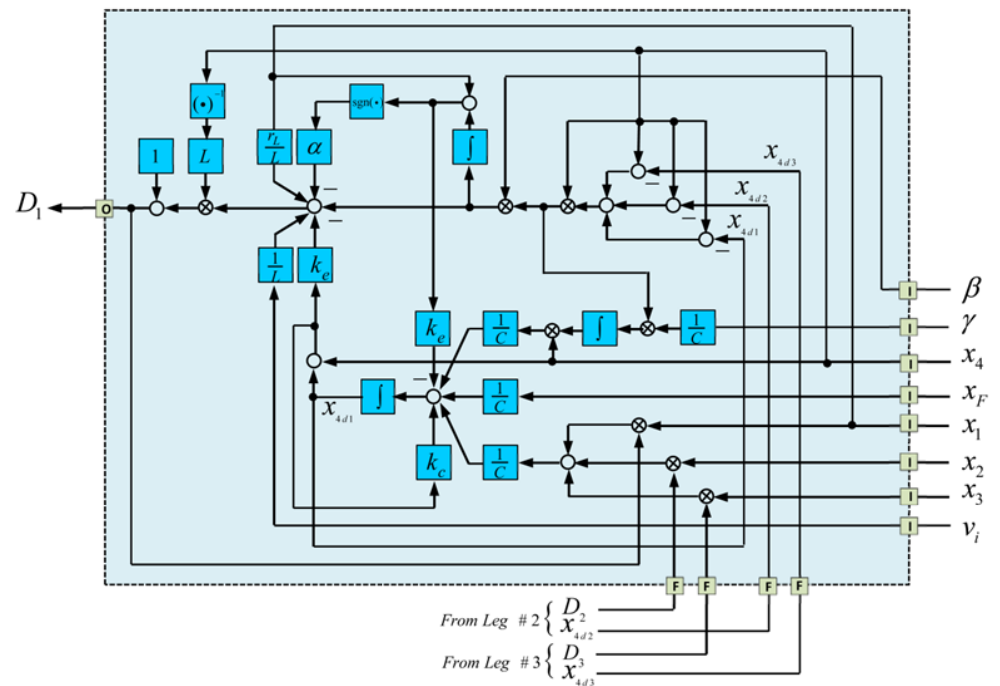
Figure 5. Realization of proposed sliding mode controller for each phase of boost converter.